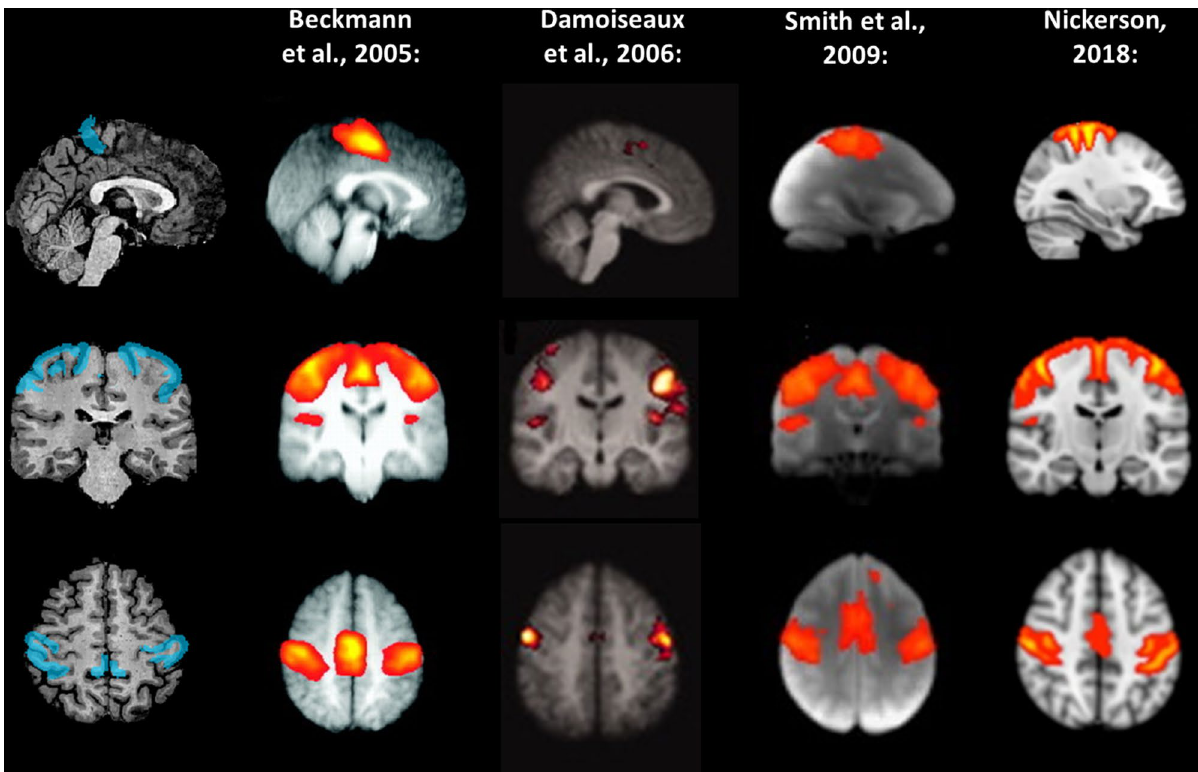
Figure 5. Left and right somatosensory seeds (cyan) used in the present study. For comparison, the sensory- motor system, as described in previous studies, is likewise depicted. Images modified from Beckmann et al. 6 , Damoiseaux et al. 7 , Smith et al. 8 , and Nickerson 9 , and generated using Microsoft®